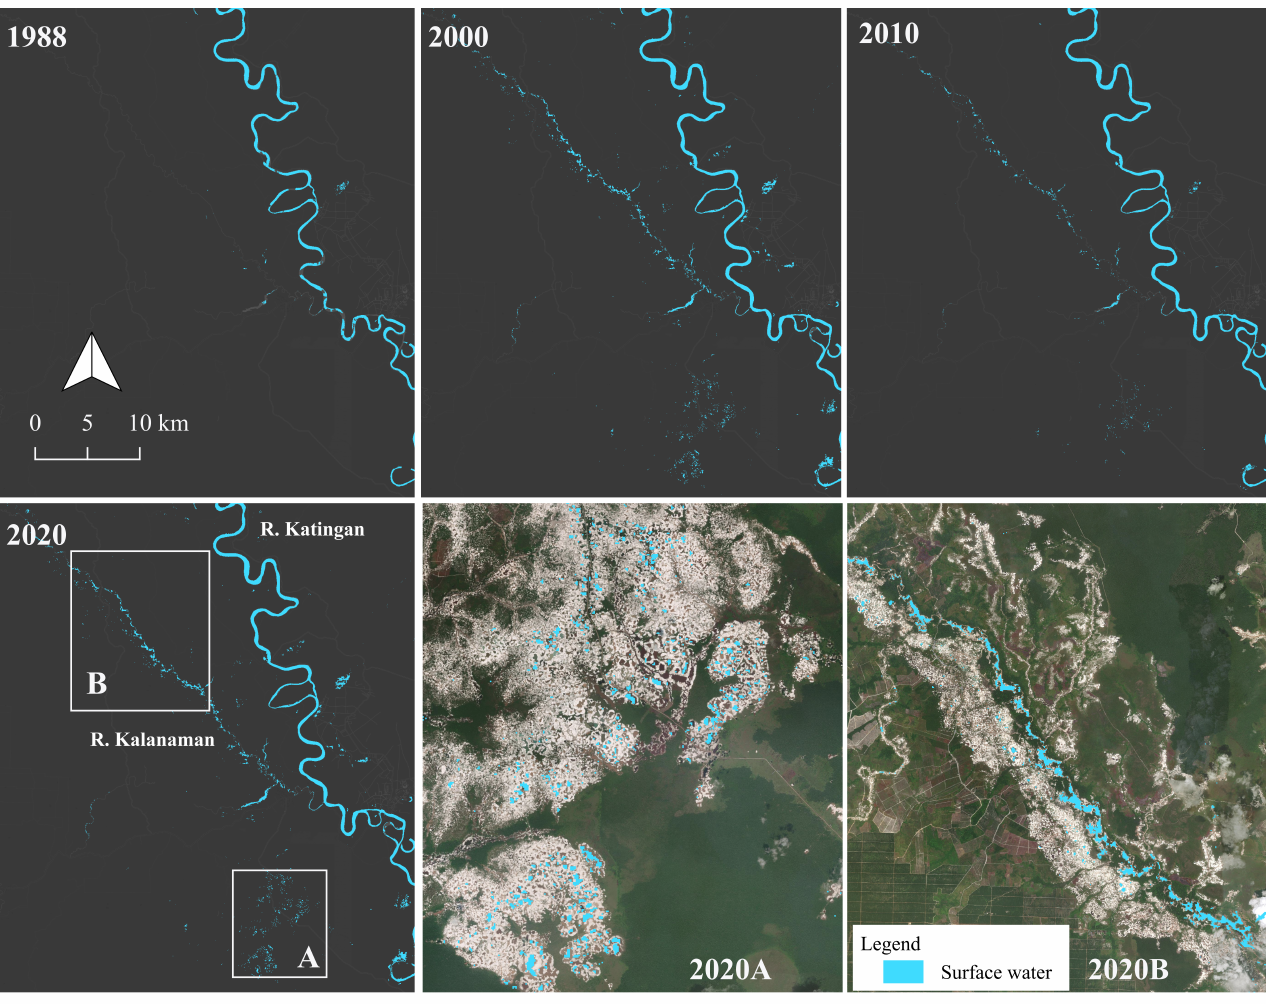
Figure 5. Changes in yearly surface